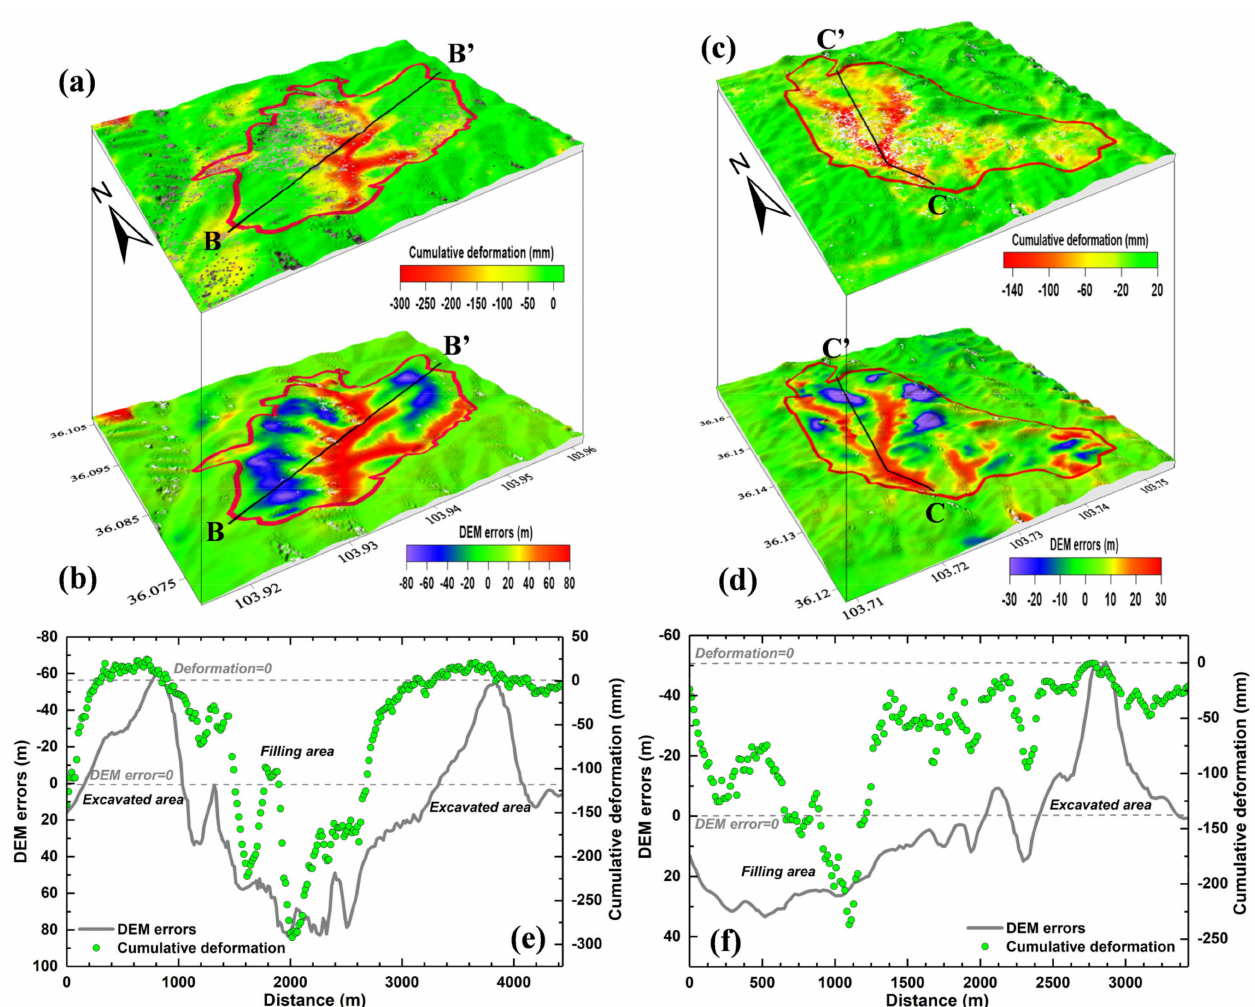
Figure 19. Relationship between surface displacements and thickness of the filling loess: ( a , b ) are the InSAR-derived cumulative displacements of Region E between December 2015 and March 2021 and the estimated DEM errors, respectively; ( c , d ) are the cumulative displacements of Region A between December 2015 and March 2021 and the estimated DEM errors, respectively; ( e , f ) are the cumulative displacements and estimated DEM errors along Profiles BB’ and CC’, respectively. The locations of Regions A and E are marked in Figure 11, and the locations of Profile BB’ and CC’ are presented in Subfigures a and c. Positive DEM errors in Subfigures b and d can be regarded as the thickness of the filling